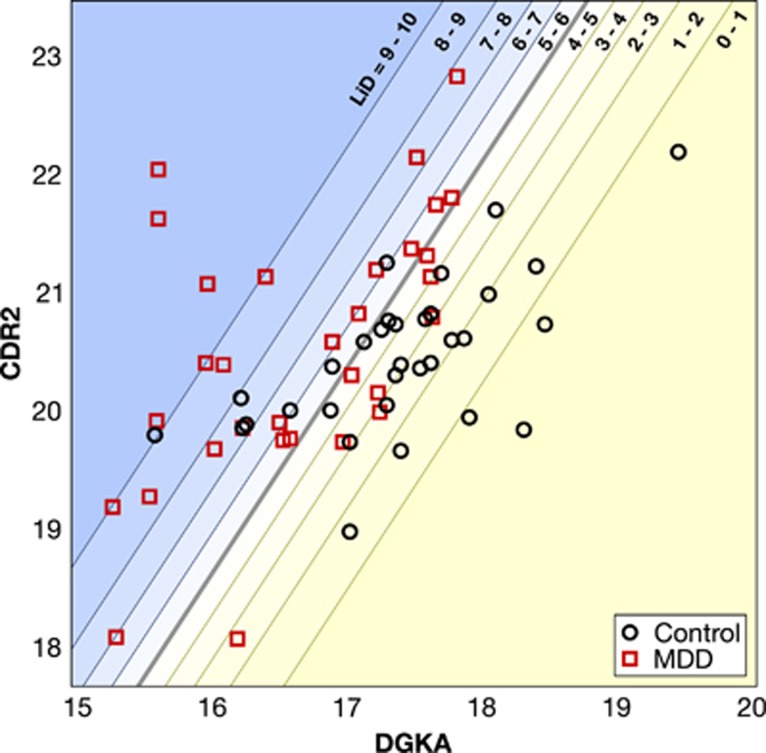
SVMs combined with a logistic equation provides quantitative LiD score corresponding to the probability of a MDD diagnosis. A logistic equation was fit on the boundary inferred by the linear SVM from the 10 most predictive transcripts. For illustrative purposes, we show the same method on the two most predictive pairwise genes, DGKA and CDR2; the full predictive model uses 10 transcripts and would be impractical to visualize. The thick line corresponds to the logistic regression inflection point and the thin lines correspond to deciles of probability of a MDD diagnosis fitted from logistic regression. The LiD score range is shown for each region. The overlaps in transcript measurements between MDD and ND control subjects highlights the inherent noise in MDD diagnoses as well as biological experiments. However, the probabilistic interpretation from logistic regression offers a diagnostic tool useful for clinicians. LiD, likelihood of depression; MDD, major depressive disorder; ND, no-disorder; SVM, support vector machine.